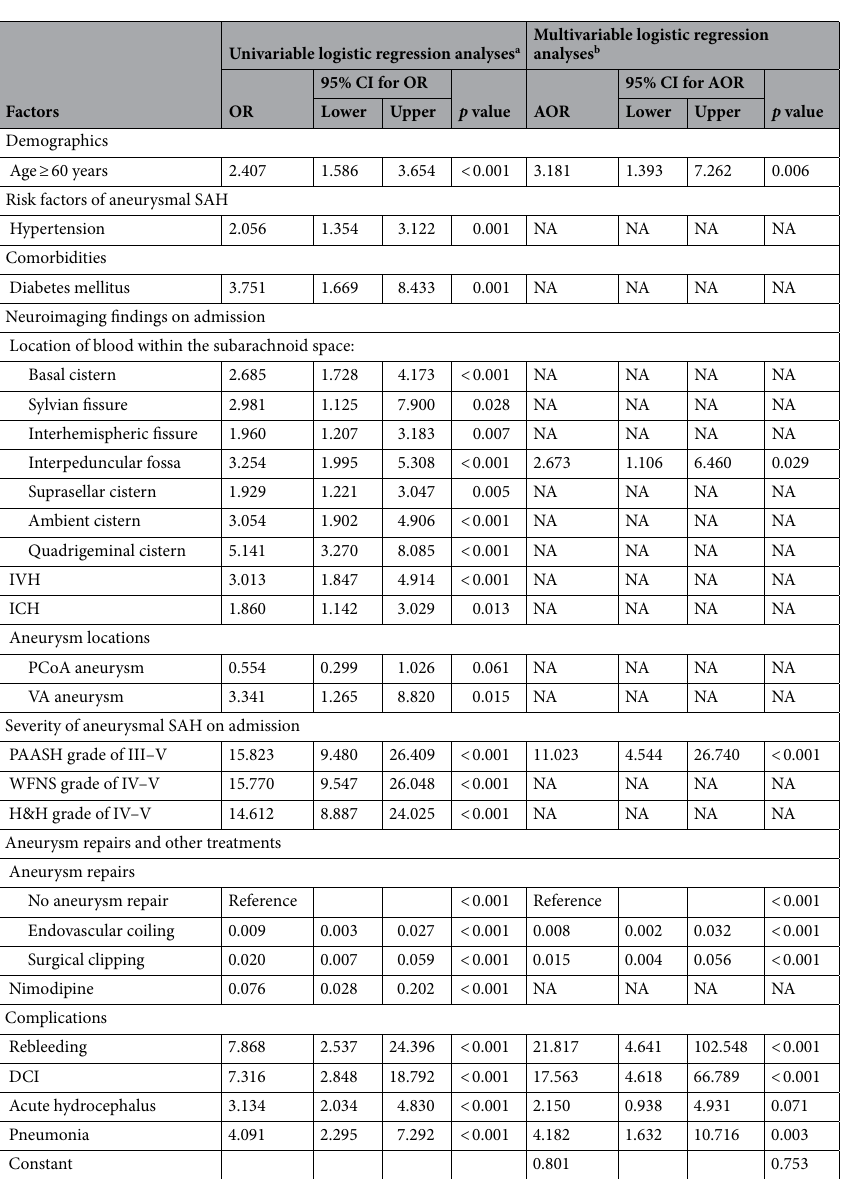
Table 5. Factors associated with 30-day poor outcomes in patients with aneurysmal subarachnoid haemorrhage: logistic regression analyses. AOR adjusted odds ratio, CI confidence interval, DCI delayed cerebral ischemia, H&H Hunt and Hess, ICH intracerebral haemorrhage, IVH intraventricular haemorrhage, mRS modified Rankin Scale, NA not available, OR odds ratio, PAASH Prognosis on Admission of Aneurysmal Subarachnoid Haemorrhage, PCoA posterior communicating artery, SAH subarachnoid haemorrhage, VA vertebral artery, WFNS World Federation of Neurosurgical Societies. a Each variable of the demographics, risk factors for aneurysmal SAH, comorbidities, initial clinical, neuroimaging and laboratory characteristics, the severity of aneurysmal SAH (i.e., the grades of PAASH, WFNS, and H&H grading scales that were either greater than or equal to the cut-off value) on admission, treatments, and complications was analysed in the univariable logistic regression model and was considered in the multivariable logistic regression model if the p value was < 0.05 in univariable logistic regression analysis, as well as clinically crucial factors. b All selected variables were included in the multivariable logistic regression model with the stepwise backward elimination method. Variables, then, were deleted stepwise from the full model until all remaining variables were independently associated with poor